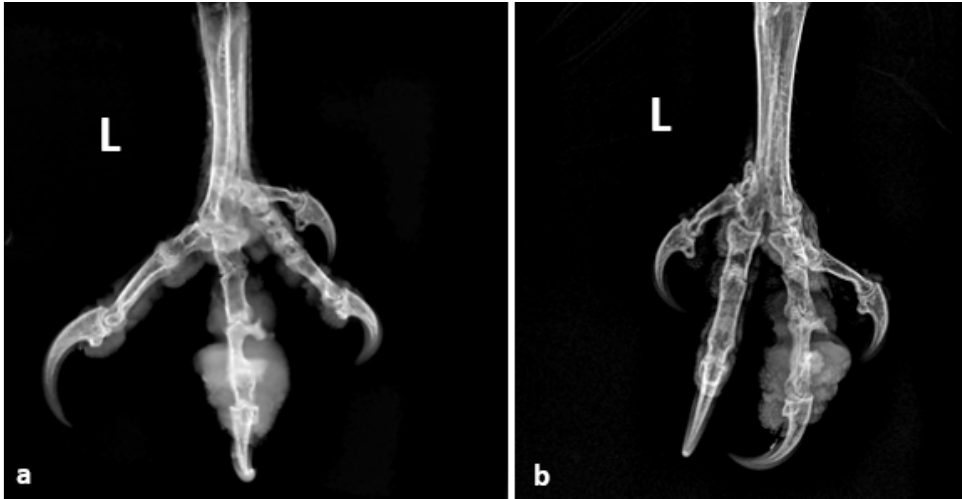
Figure 2. Verreaux’s eagle owl feet immediately following removal of the cable tie. Lateral ( a ) and DP ( b ) radiographs taken following removal of the cable tie to ensure no fractures had occurred during the removal process.